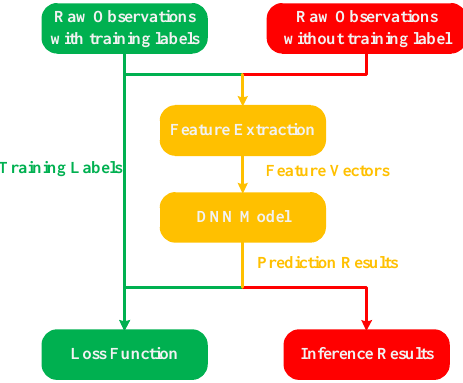
Figure 1. The framework of the proposed RAIM-NET.